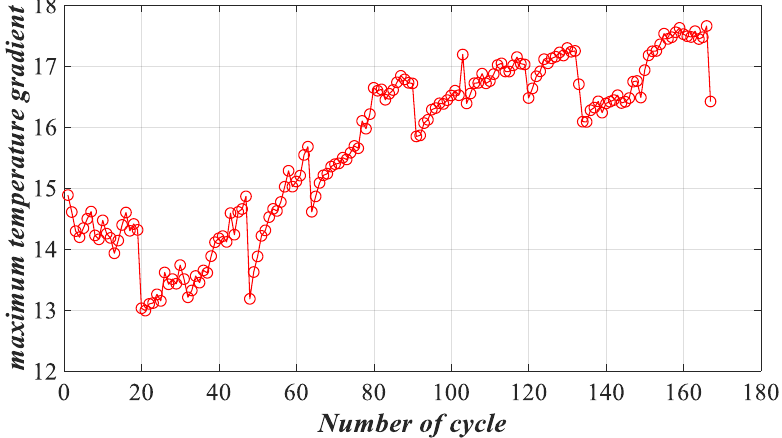
Figure 13. Temperature gradient indicator.